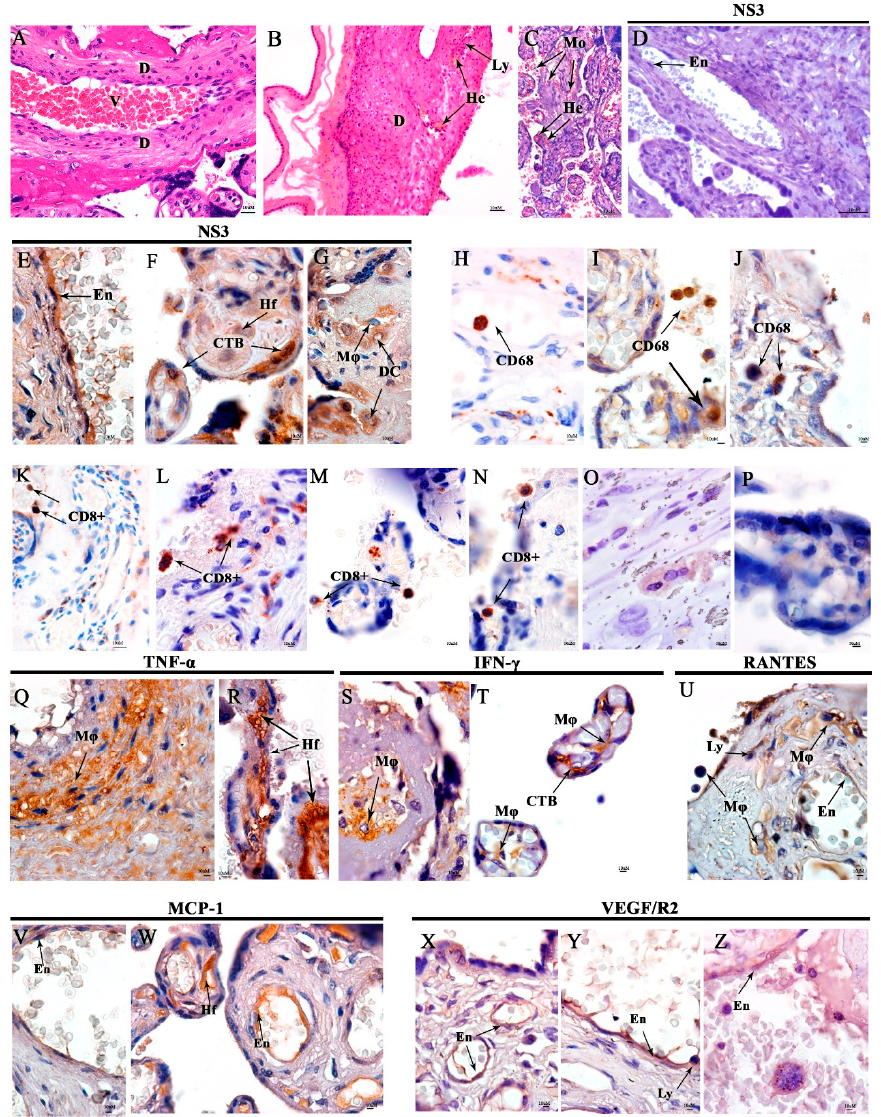
Figure 2. Histopathological and immunohistochemistry analysis of the placenta. ( A ) Non-DENV patient stained with HE and presenting normal maternal decidua ( D ) and blood vessels (V). ( B ) Maternal decidua (D) from the DENV case presenting focal hemorrhage and lymphocytic infiltrates. ( C ) Chorionic villus with mononuclear infiltrate (Mo) and haemorrhage (He) and also intervillus space in the DENV case. ( D ) Placenta control with no DENV NS3 protein detection. ( E ) DENV NS3 protein detection in endothelial cells (En) from the maternal vessel, ( F ) in the cytotrophoblasts (CTB) and Hofbauer cells (Hf), ( G ) in decidual cells (DC), and macrophages (Mø) in the infected placenta. ( H ) CD68 detection in negative control and in the DENV case ( I , J ). ( K ) CD8 + T cells detection in negative control and in the DENV case ( L – N ). ( O , P ) Representative negative control of cytokine and inflammatory mediators from a non-DENV case ( Q , R ) Expressing TNF- α in macrophages (Mø) and Hofbauer cells (Hf) in the DENV-case. ( S ) Expressing IFN-y in macrophages (Mø) in maternal region, ( T ) in Macrophages (Mø) and cytotrophoblasts (CTB) in chorionic villi. ( U ) Expressing RANTES in Macrophages (Mø), endothelial cells (En), and lymphocytes (Ly) in the maternal region. ( V ) Endothelial cells (En) expressing MCP-1 in the maternal region and, ( W ) endothelial cells (En), and Hofbauer cells (Hf), both in chorionic villi. ( X – Z ) Macrophages (Mø), endothelial cells (En) and lymphocytes (Ly) expressing